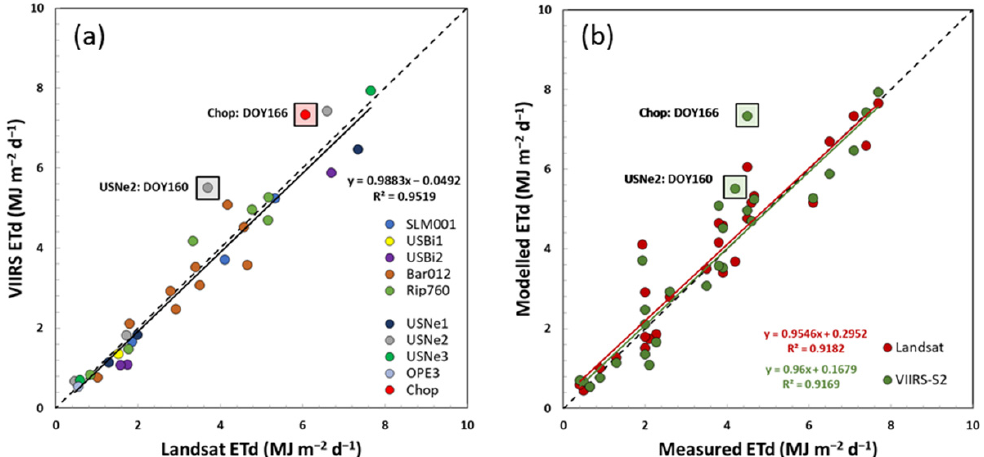
Figure 5. ( a ) Comparison of modeled Landsat and VIIRS daily ET on common days of overpass in 2018 at all the flux sites. ( b ) The same as ( a ), but between modeled and measured ET. DOY 166 at the Choptank site and DOY 160 at USNe2, highlighted with boxes, were shown for comparison but not used in the linear regression due to cloud contamination in VIIRS LST undetected by the VIIRS cloud mask.